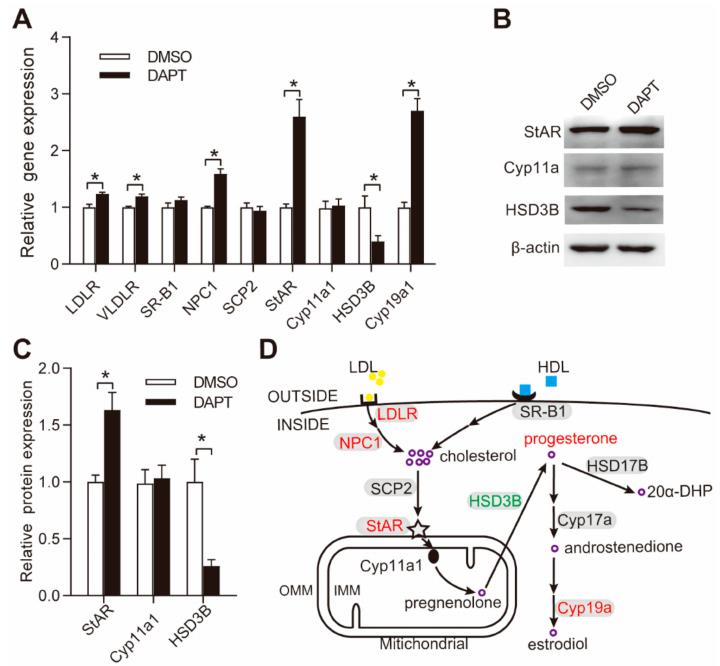
Figure 2. E ff ects of DAPT treatment on the expression of proteins involved in steroidogenesis in